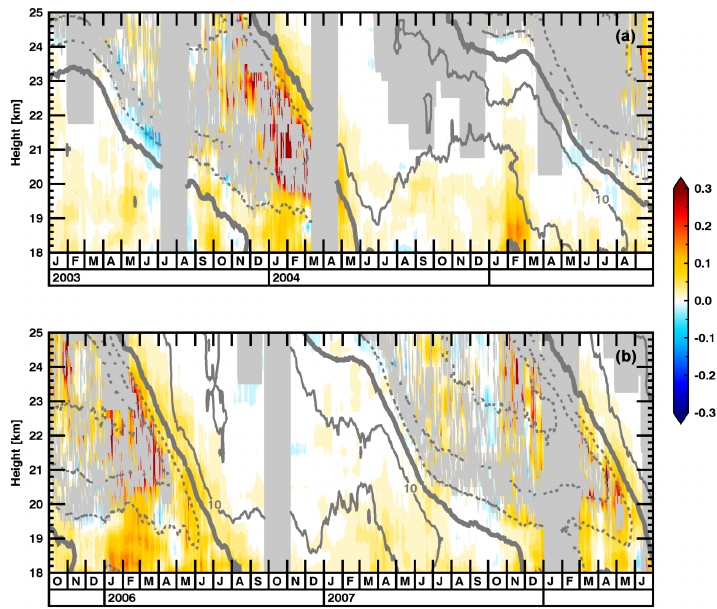
Figure 4. Time series of momentum fluxes from the Manus ARM site. Plotted fields are as in Fig. 3. The span here covers 1 January 2003 through 30 June 2008. Momentum flux is in units of mPa and zonal wind contour spacing (gray contours) is 10ms − 1 .